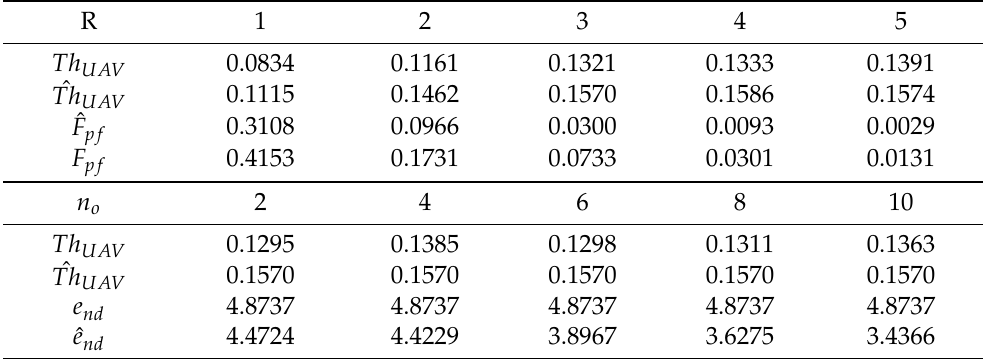
Table 7. Sensitivity table of performance to E-MAVLink and E-MAC